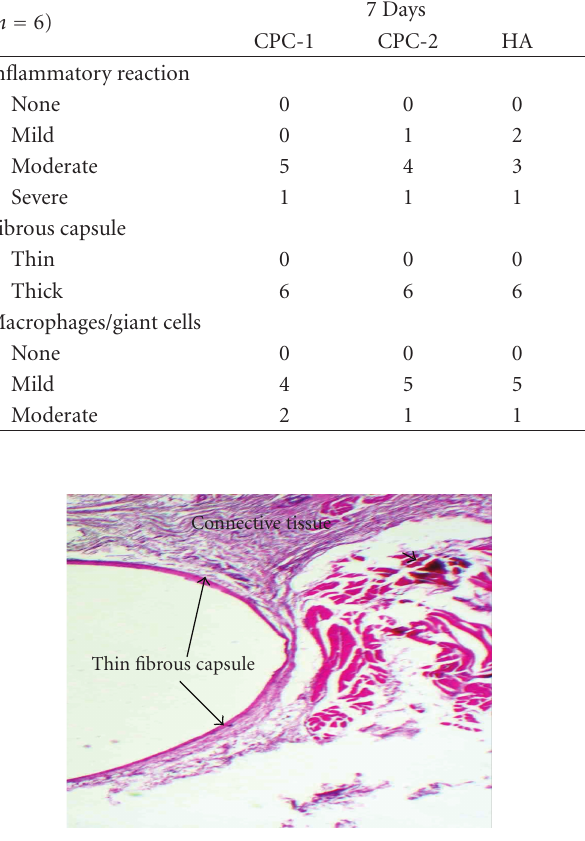
Figure 7: Section of tissue from area of CPC-2 implantation which demonstrates a thin fibrous capsule and a normal connective tissue denoting complete healing at 90 days. Note that this reaction is typical of all experimental implanted materials at 90 days H/E